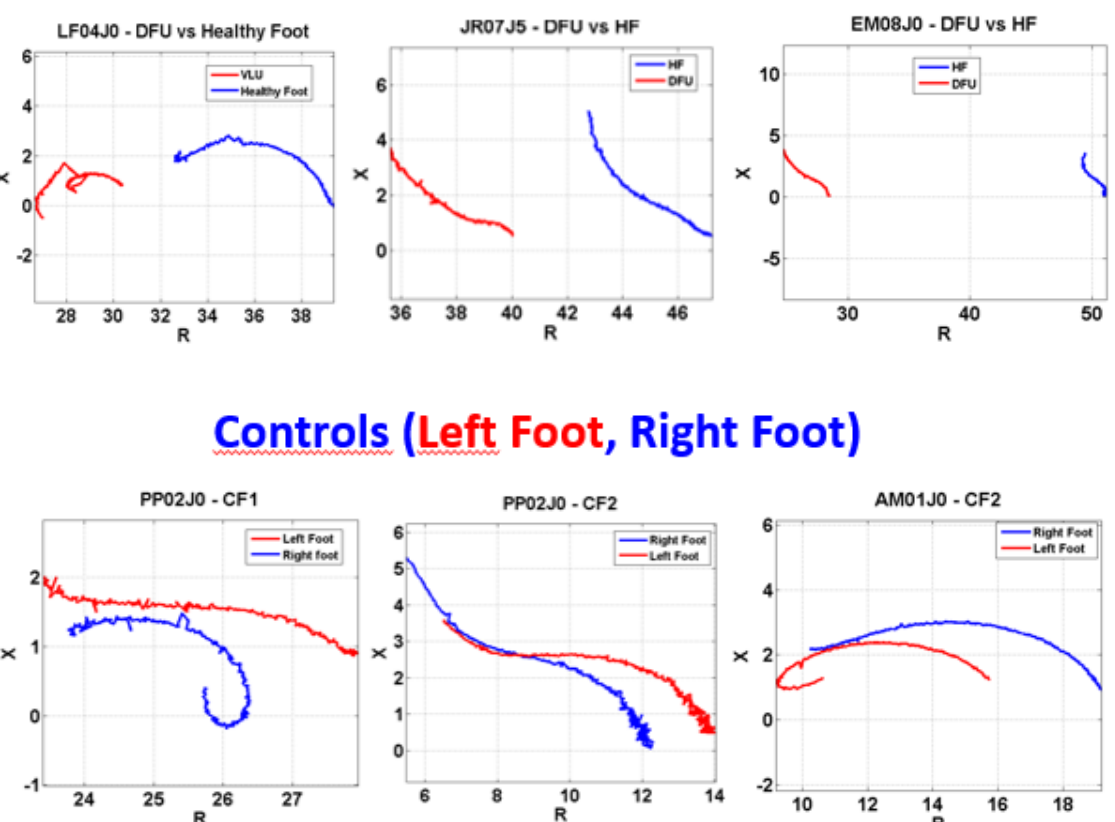
Figure 2: Top: Nyquist Plots on 3 diabetic patients with chronic wounds on one foot: DFU (red), comparison between the DFU (red) and the healthy foot (blue). Bottom: Nyquist plots on 2 healthy volunteers, comparison between the left foot (red) and the right foot